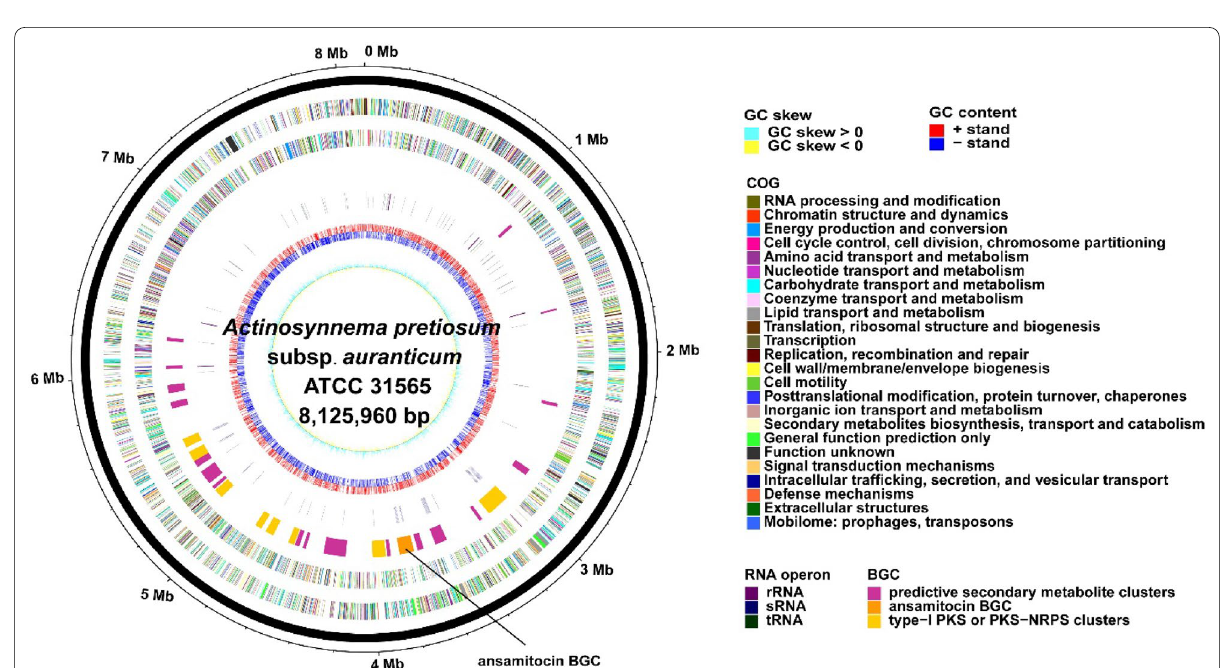
Fig. 5 Complete genome of A. pretiosum subsp. auranticum ATCC 31565. The seven circles (from outside in) represent the genome region of ATCC 31565, CDSs on the forward strand, CDSs on the reverse strand, locations of predictive secondary metabolite clusters, distribution of rRNA, sRNA and tRNA operon, GC content and GC skew of